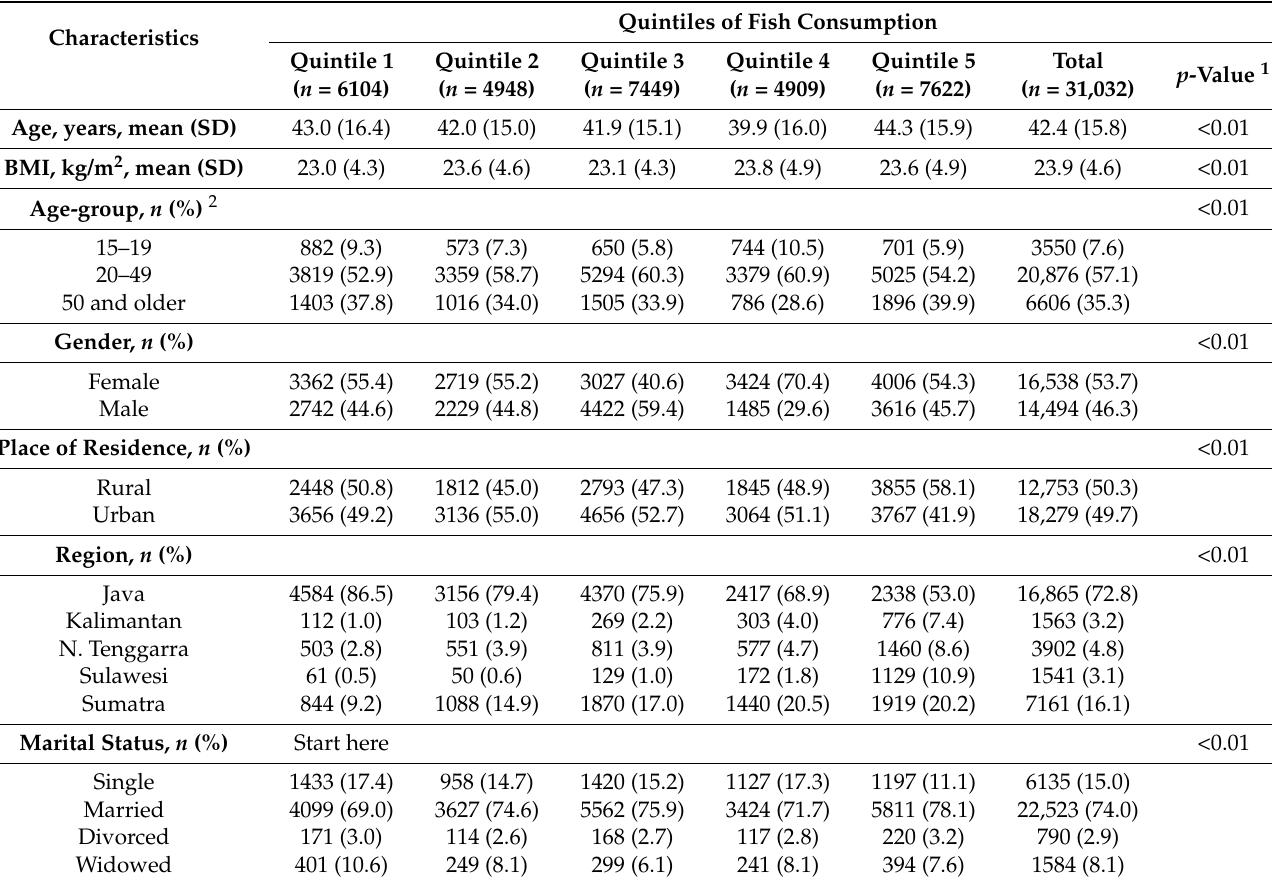
Table 5. Fish Consumption Quintiles by Sociodemographic